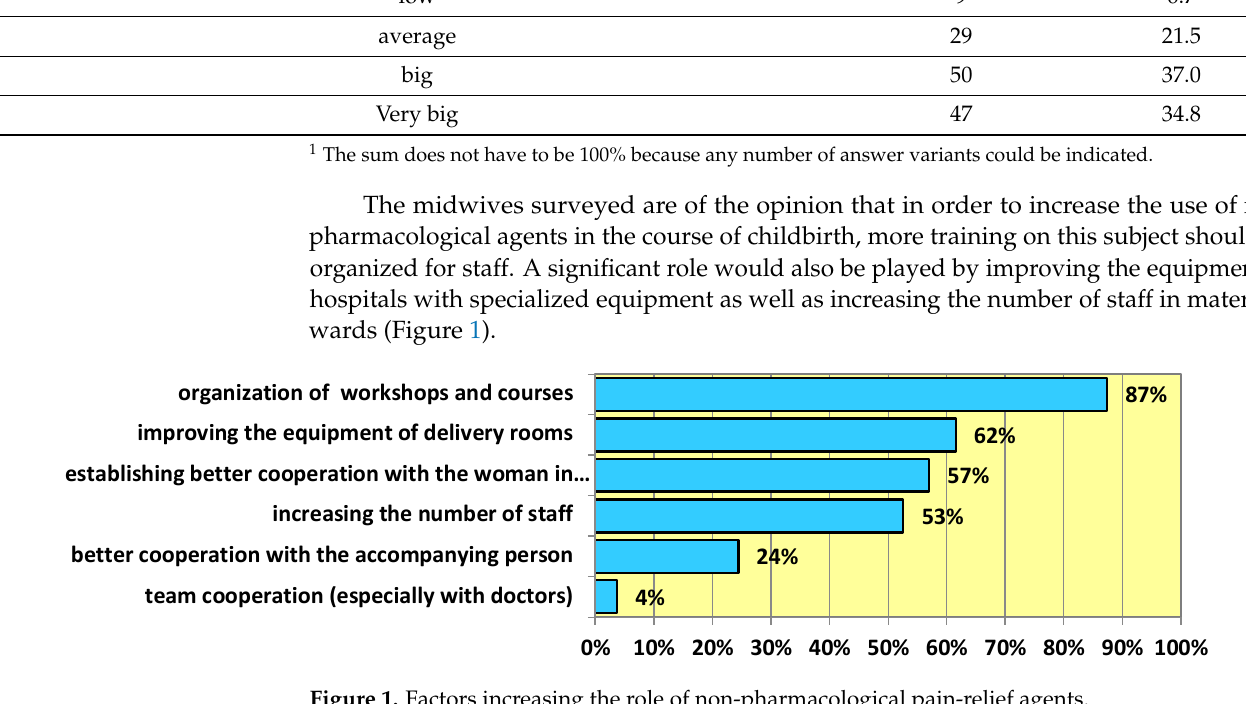
Figure 1. Factors increasing the role of non-pharmacological pain-relief agents.